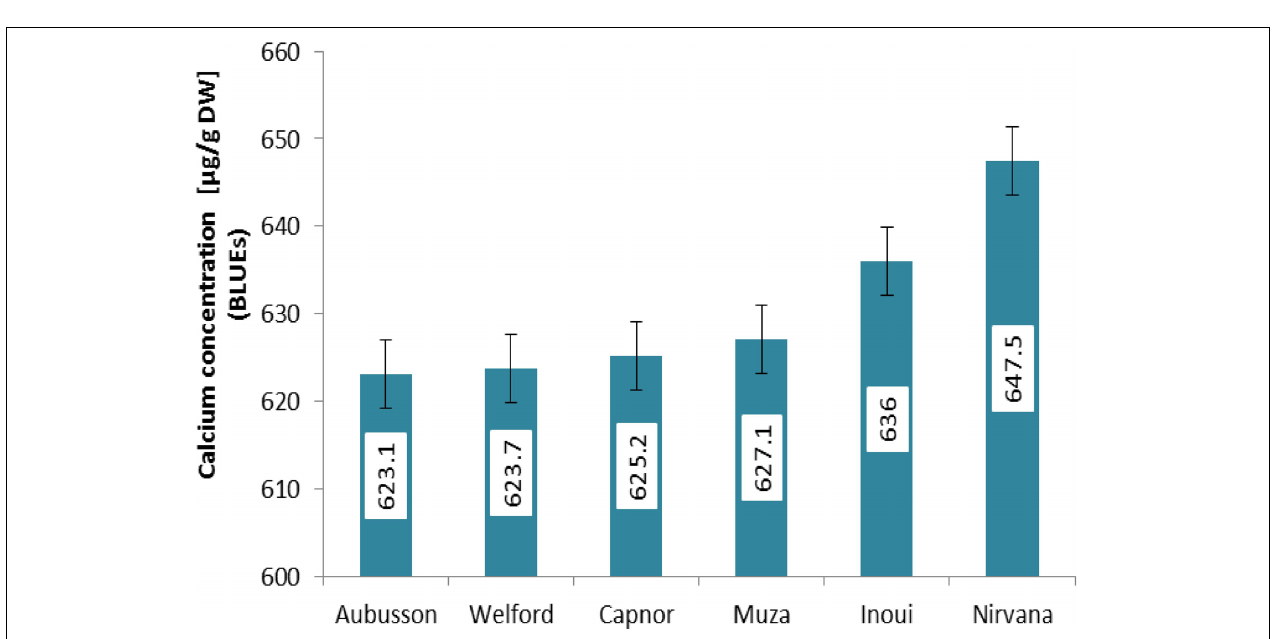
FIGURE 2 | Calcium concentrations of the top 6 accessions [Ca > 600 ( µ g g − 1 DW)] based on BLUE values ± SE. Numbers on the y -axis represent the calcium concentration.